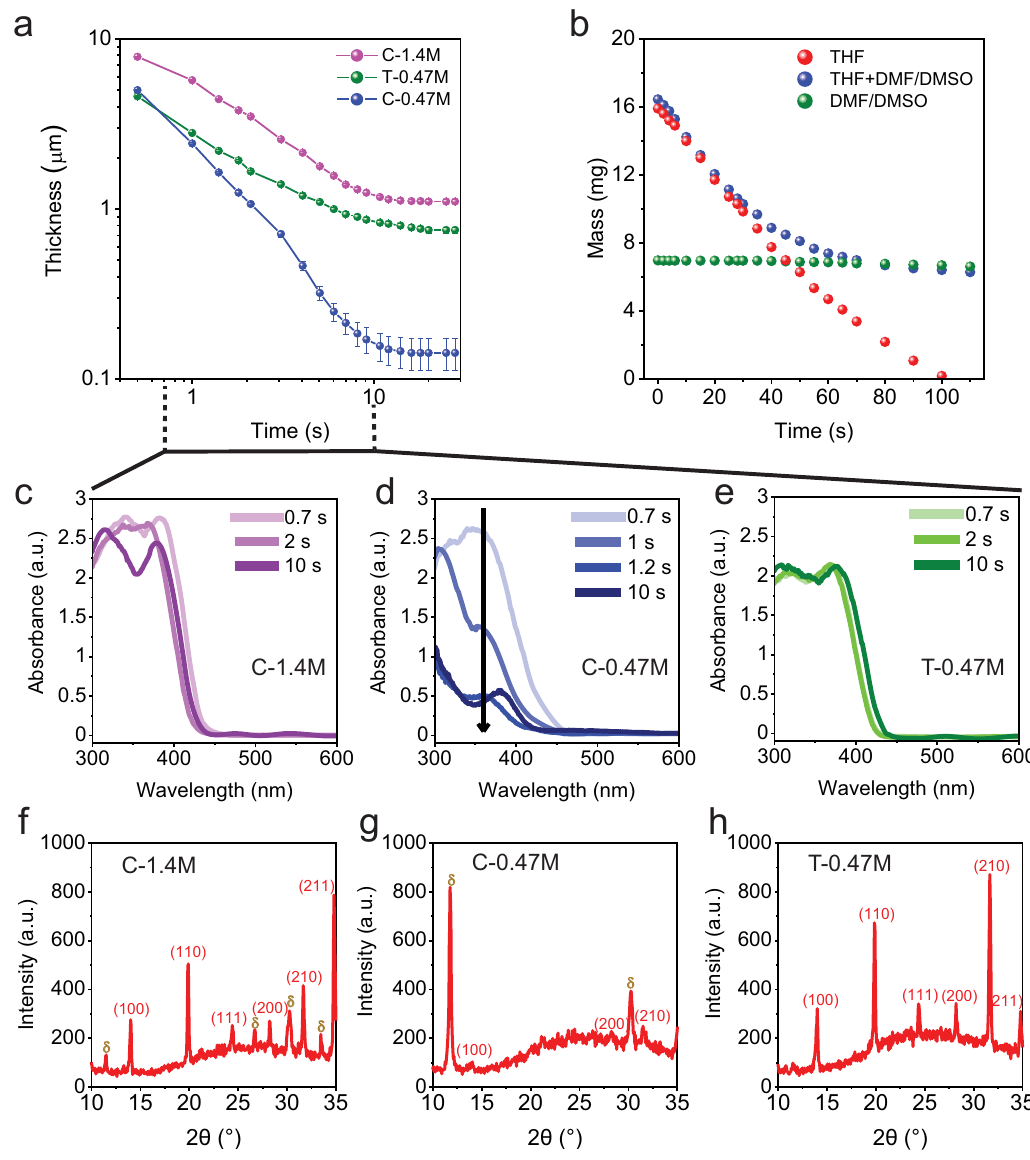
Fig. 4 In situ UV – vis investigations and solvent evaporation rate measurement. a Thinning behavior of the solutions. b Solvent evaporation rate of THF, DMF/DMSO, and the mixture of these two. c – e Time-evolution of the solution absorbance in UV region during spin. f , g X-ray diffraction on the as- cast fi